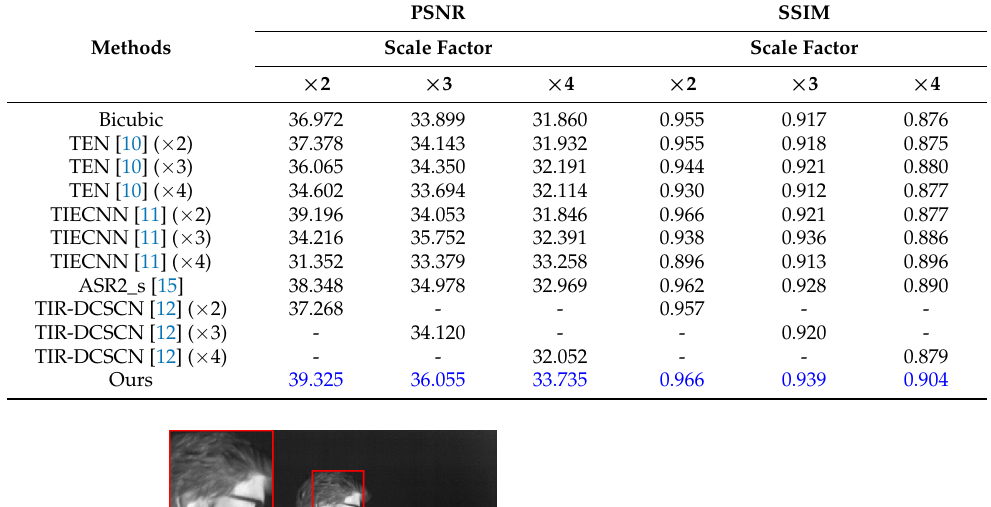
Table 5. The average results of the PSNR and SSIM for scale factors × 2, × 3, and × 4 (-: when it is impossible to measure due to the network structure; blue-colored: the best case). PSNR SSIM Methods